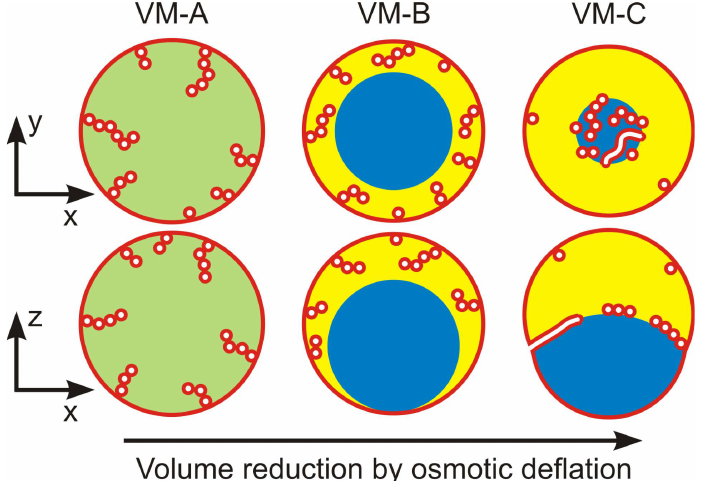
Figure 18. Three nanotube patterns corresponding to the distinct vesicle morphologies VM-A, VM-B, and VM-C observed along a deflation path that moves the interior PEG-dextran solution into the two-phase coexistence region: Schematic views of horizontal xy -scans ( top row) and of vertical xz - scans ( bottom row) across an individual vesicle, the volume of which is reduced by osmotic deflation. In all cases, the tubes are filled with the exterior solution (white). For the morphology VM-A, the interior polymer solution is uniform (green), whereas it is phase separated (blue-yellow) for the morphologies VM-B and VM-C, with complete and partial wetting of the membrane by the PEG-rich α phase (yellow). For the VM-B morphology, the nanotubes explore the whole PEG-rich α droplet but stay away from the dextran-rich β droplet (blue). For the VM-C morphology, the nanotubes adhere to the αβ interface between the two aqueous droplets, forming a thin and crowded layer at this interface